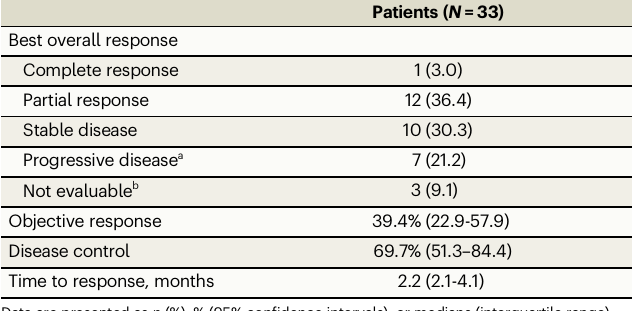
Table 2 | Tumor responses